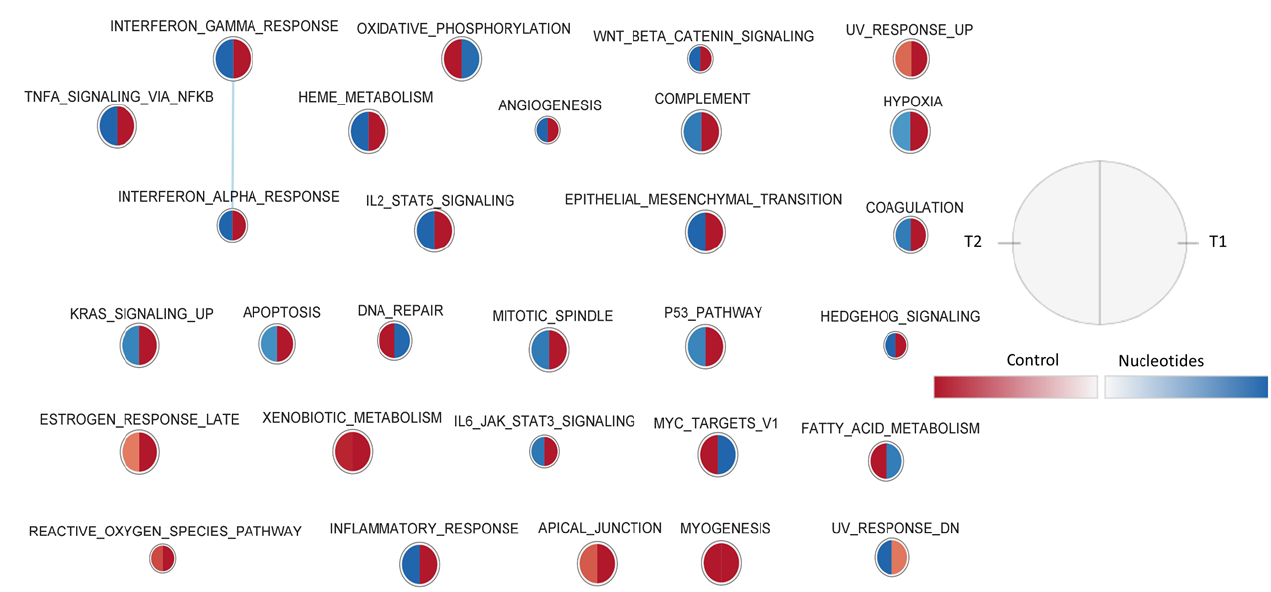
Figure 4. Effect of diet on peripheral blood gene sets enriched in the two sampling times, using the Hallmark collection. The nodes represent the enriched gene sets in the CO group (red) and NU group (blue). For each node, the right semicircle represents T1 and the left semicircle represents T2. The node size represents the number of genes in each gene set. The threshold for node insertion was FDR q-value < 0.05. The nodes were joined if the overlap coefficient was ≥0.375.